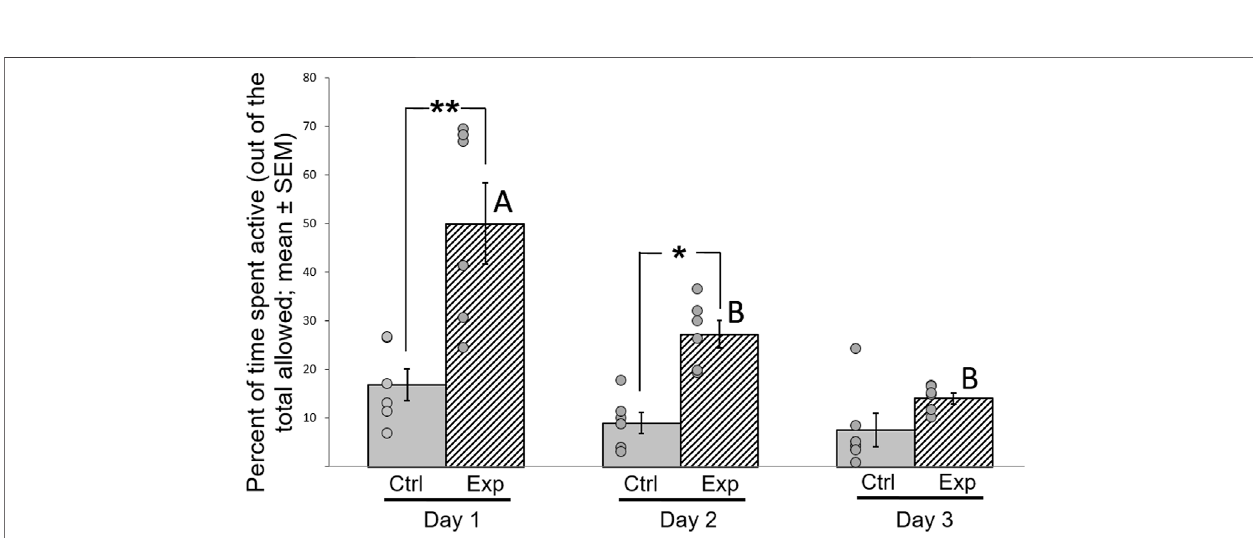
FIGURE 6 | Effect of GSK-3 β inhibition on motor activity of zebra fi nches during the 3 days ofthe test. Activity was calculated as percentage (mean ± SEM) of time spentmovinginthecage,outofthetotaltimeallowed.N=6birds/group;* p < 0.01;** p < 0.001.Ctrl=controlbirds;Exp=GSK-3 β -inhibitedbirds.Lettersrepresentthe signi fi cance within the experimental group between days. Dots represent data points of individual birds.